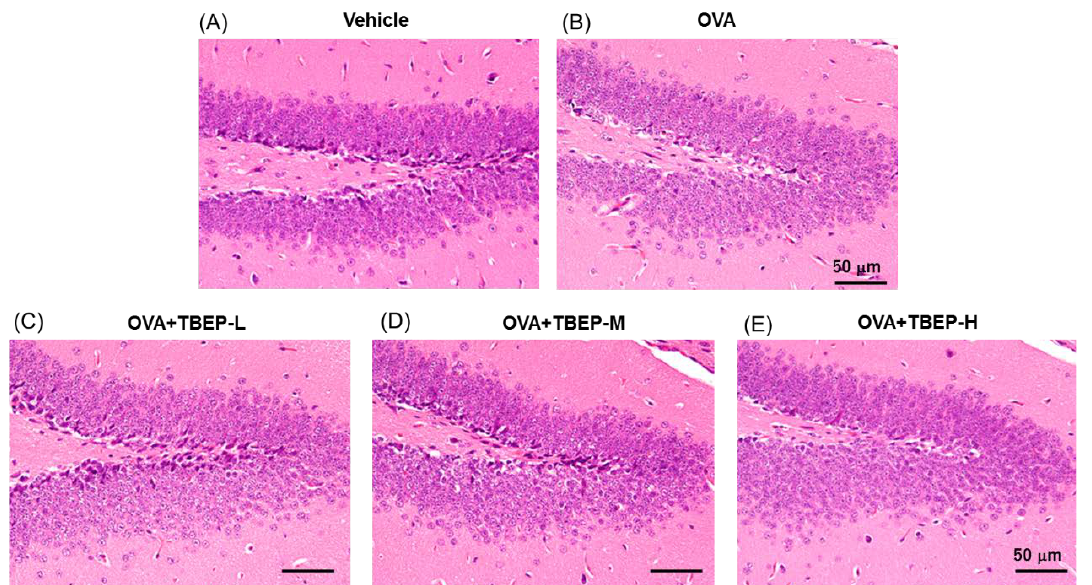
Figure 6. Histological analysis of dentate gyrus of the hippocampus. H&E stain in ( A ) vehicle, ( B ) OVA, ( C ) OVA + TBEP-L, ( D ) OVA + TBEP-M and ( E ) OVA + TBEP-H. (Scale bar = 50 μm).